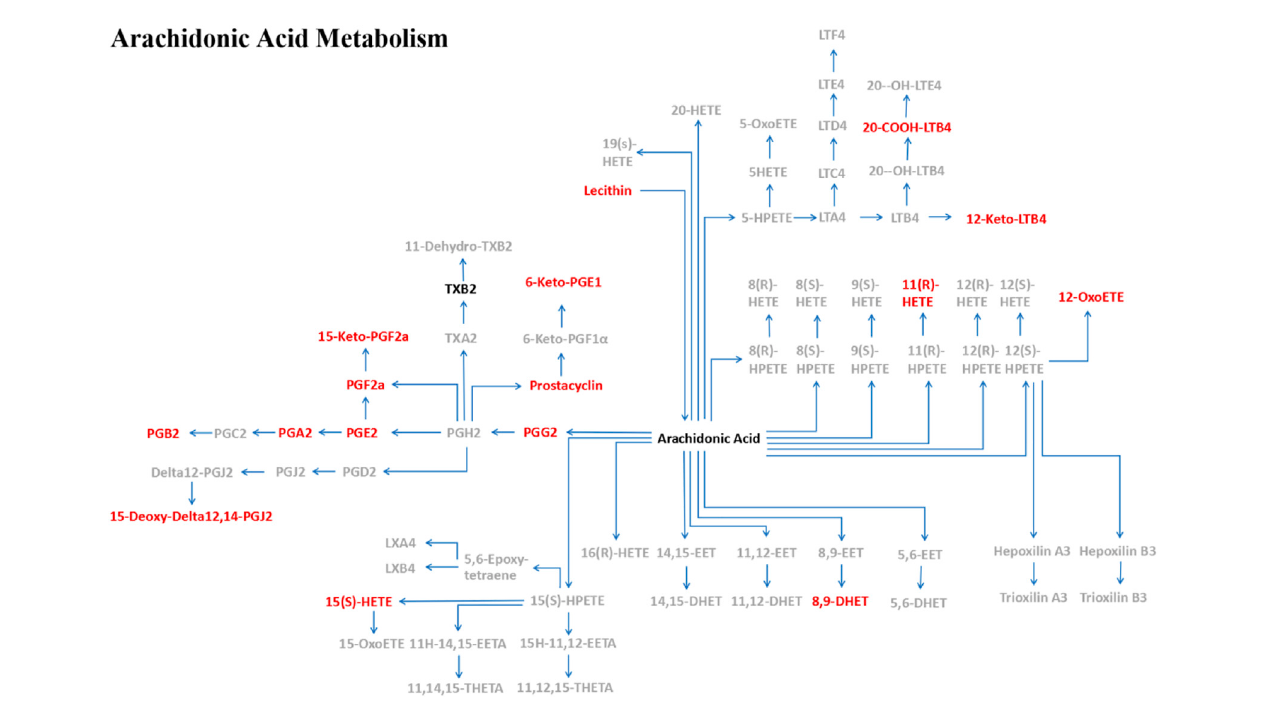
The pathway of arachidonic acid metabolism in moDCs with leonurine administration. After moDCs were administrated with leonurine, 16 metabolites (red) were signi fi cantly upregulated while 2 metabolites (black) were signi fi cantly downregulated in the pathway of arachidonic acid metabolism. 6-Keto- PGE1: 6-Ketoprostaglandin E1; 8,9-DHET: 8,9-DiHETrE; 12-Keto-LTB4: 12-Keto-leukotriene B4; 12-OxoETE: 12-KETE; 15-Deoxy-Delta12,14-PGJ2: 15- Deoxy-d-12,14-PGJ2; 15-Keto-PGF2a: 15-Keto-prostaglandin F2a; 20-COOH-LTB4: 20-Carboxy-leukotriene B4; Lecithin: